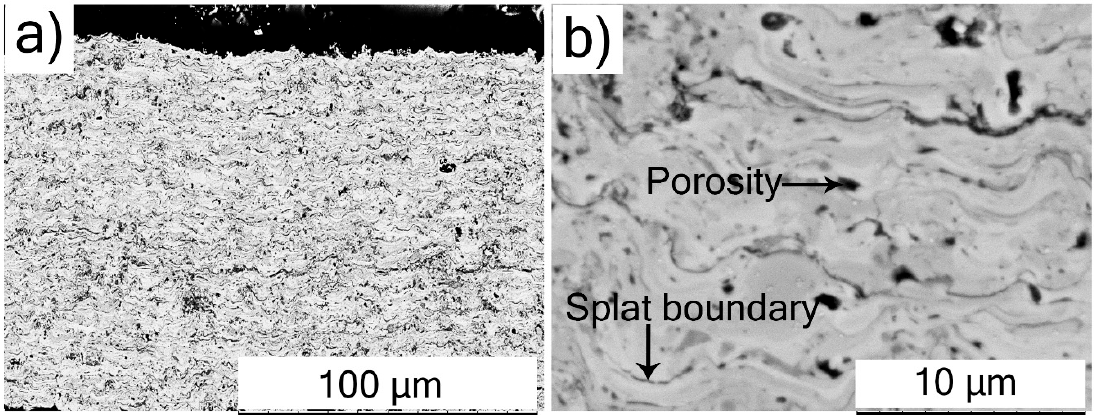
Figure 6. SEM micrographs of cross sections of SPS-deposited Cr 3 C 2 coating: ( a ) low magnification; ( b ) high magnification.